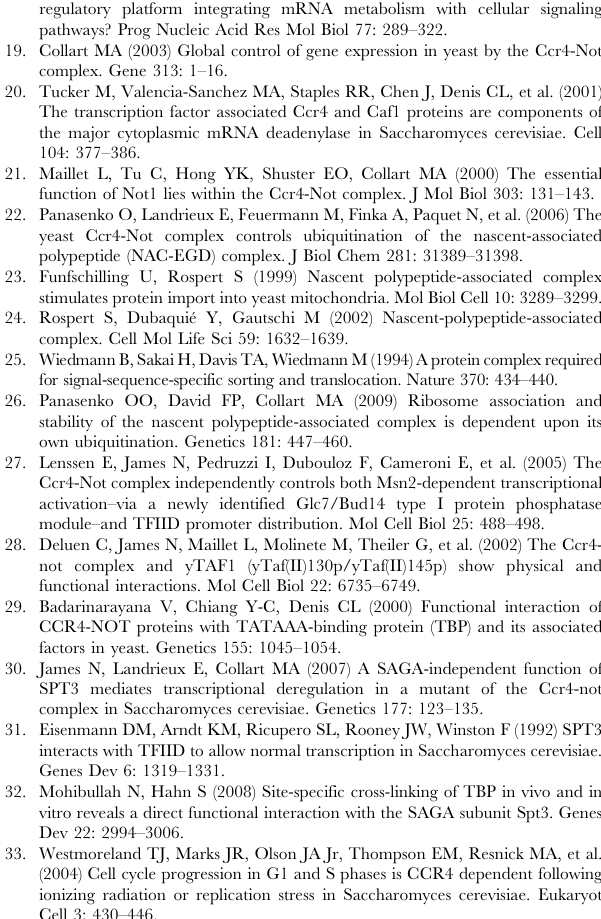
Table S2 List of the peptides identified by mass spectrometry with scores for identified proteins.